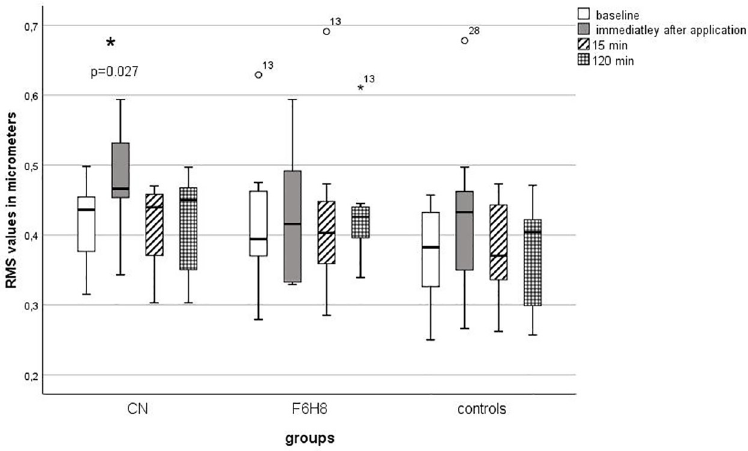
Fig 3. RMS values (in μ m) at baseline and consecutive measurements. The measurement values up to 120 min after application were compared with the baseline using the Wilcoxon test. All p-values were adjusted for 3 comparisons according to the Bonferroni method. An asterisk with the corresponding p-value indicates a significant change compared to the baseline. RMS = Root Mean Square; μ m = micrometer; CN = cationic nanoemulsion; F6H8 =